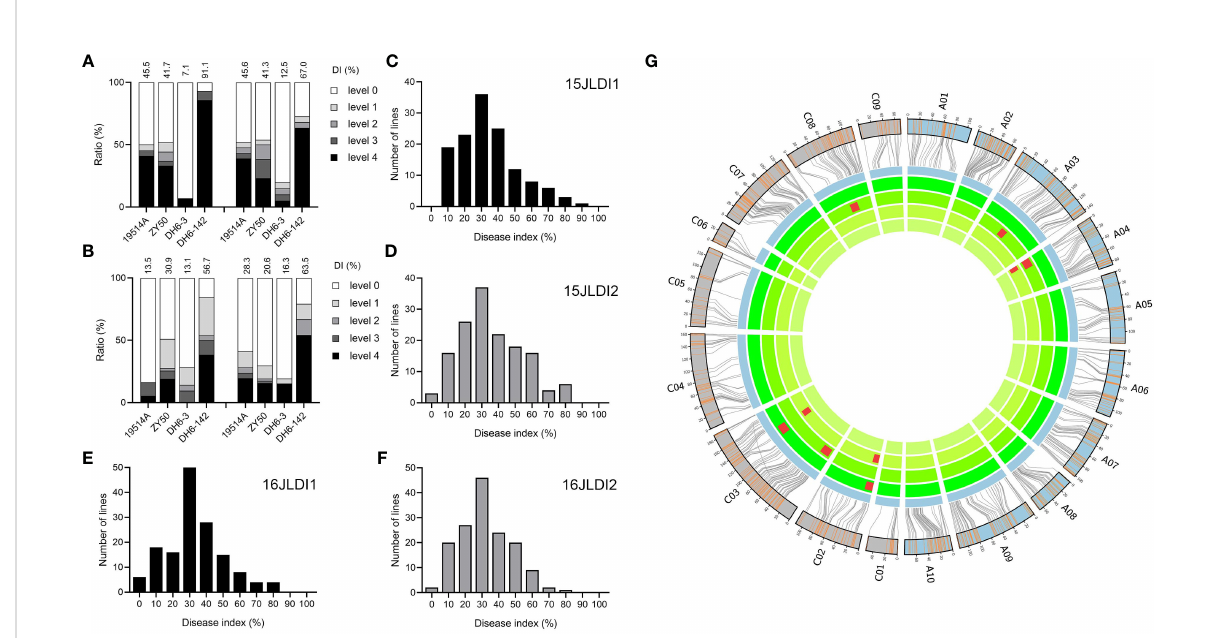
FIGURE 2 Phenotype and quantitative trait loci (QTL) mapping of natural infection experiment. (A) Disease indices (DIs) of the two parents and two double haploid (DH) lines in two replicates in 2015. The histograms represent the ratio of plants with different disease levels. (B) DIs of the two parental lines and two DH lines of two replicates in 2016. (C – F) Distribution of DIs of the DH population in 2015 (C, D) and 2016 (E, F) . (G) Genetic linkage map and locations of QTLs for DI. From inside to outside, the four cycles represent 15JZDI1, 15JZDI2, 16JZDI1, and 16JZDI2. The two outmost cycles show a comparison of the linkage and physical maps of Brassica napus